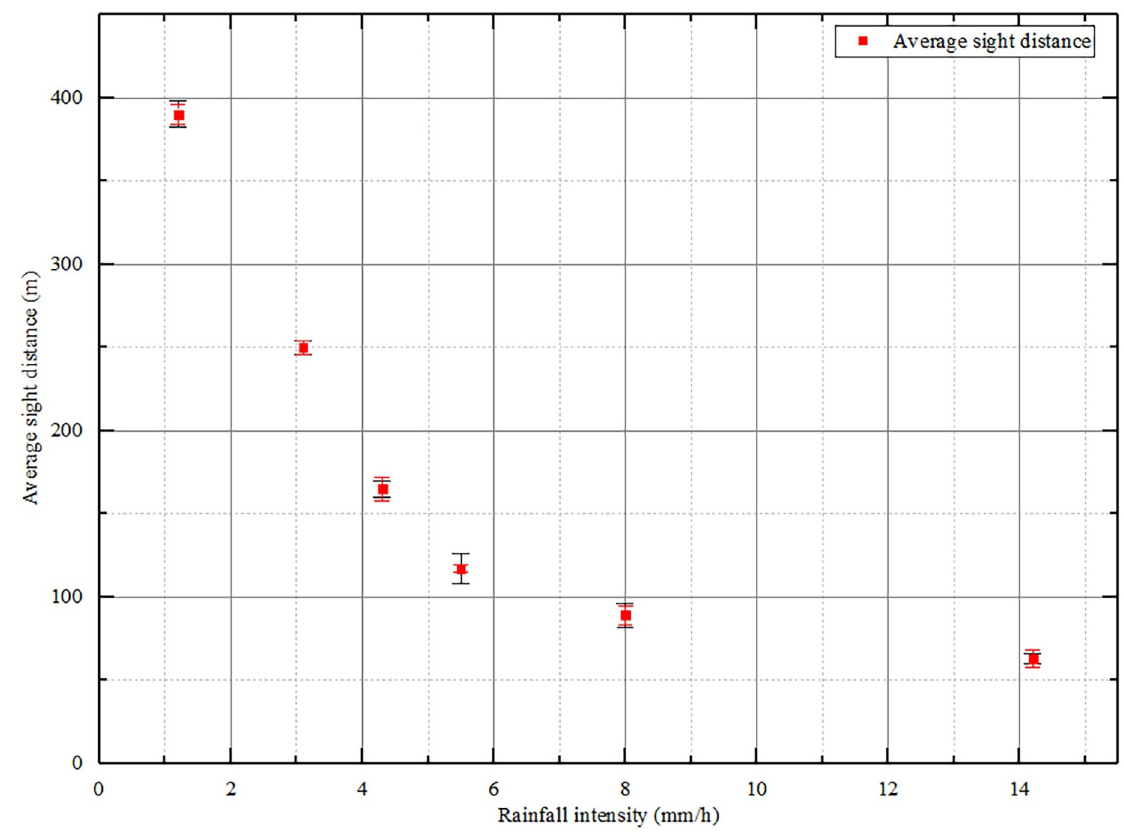
Fig 3. Average sight distance as a function of rainfall